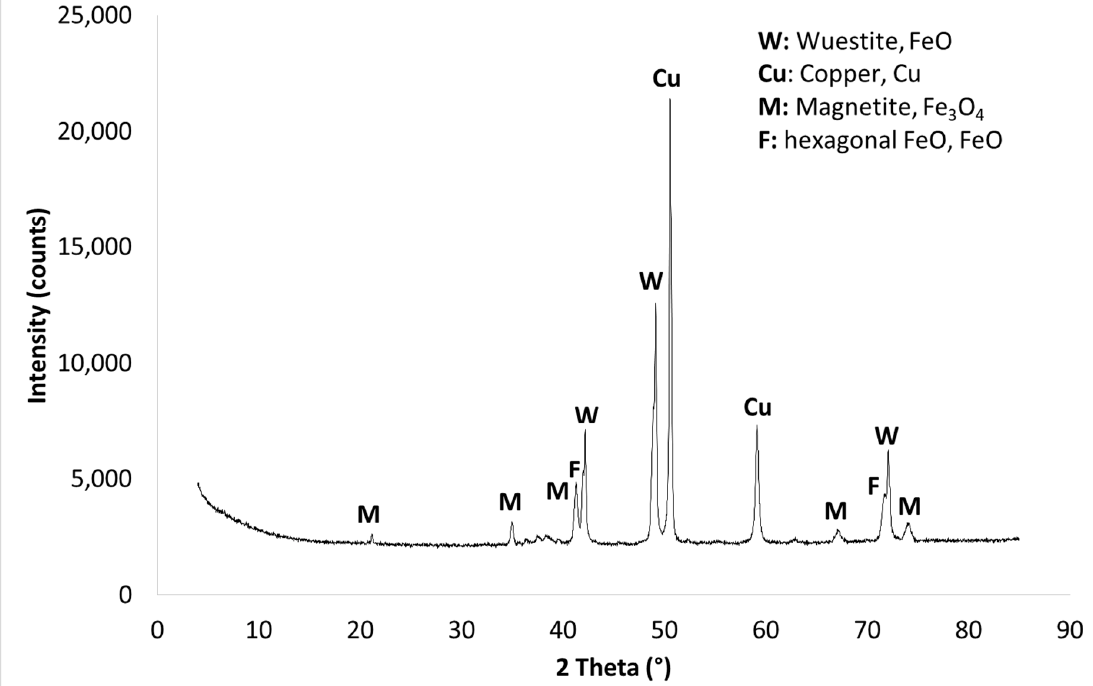
Figure 7. XRD pattern of the thermally treated abrasion product of sample A.